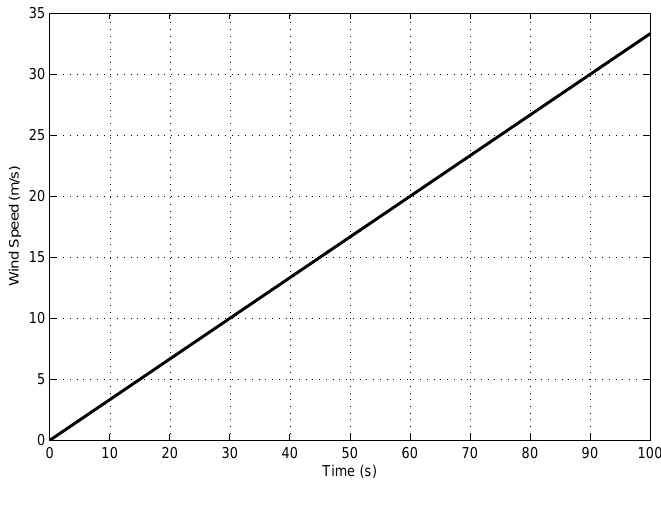
Figure 11. Ramp wind speed input.